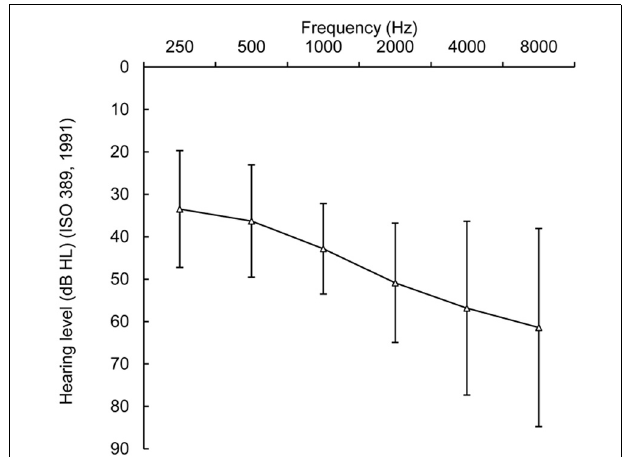
FIGURE 1 | Means and SDs (error bars) of the unaided pure-tone audiometric thresholds of the hearing-impaired participants. Hearing thresholds are averaged over both